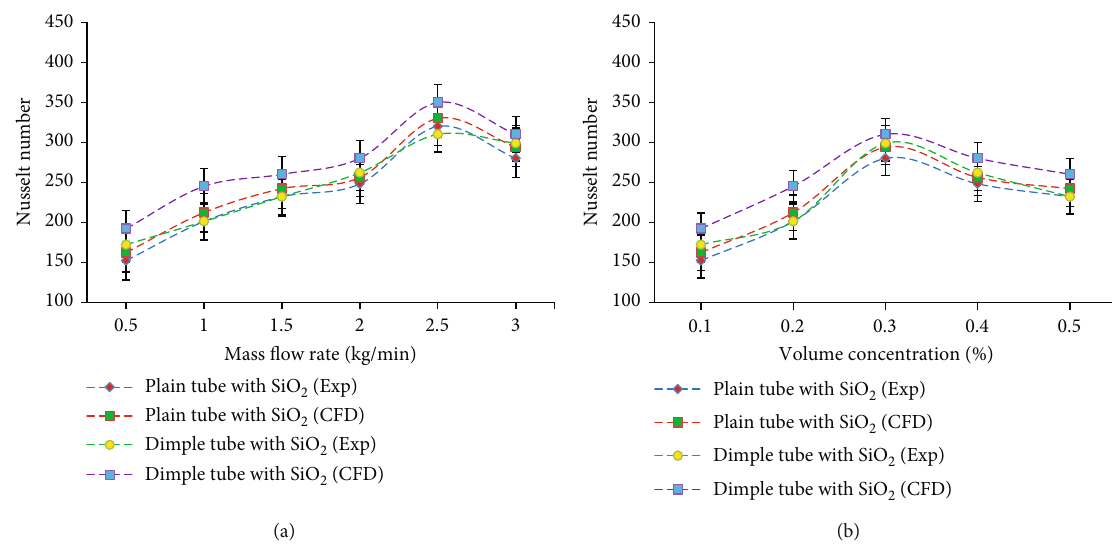
Figure 10: (a) Mass fl ow rate vs. Nusselt number. (b) Volume concentration vs. Nusselt number.